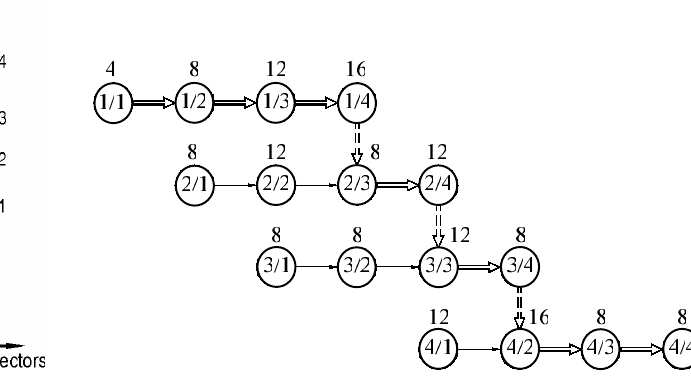
Fig 4. Cyclogram with controlling path (course 1) (Units, Process 4, …, Sectors)